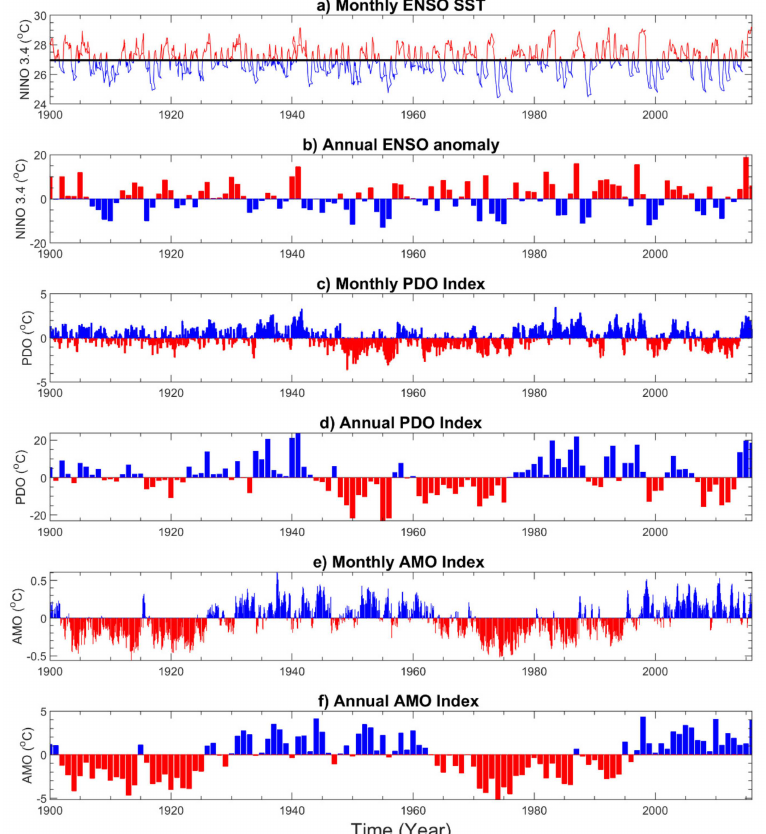
Figure 4. Long-term monthly and annual record of the three ocean–atmosphere interaction modes. ( a ) Monthly El Niño–Southern Oscillation (ENSO) sea surface temperature (SST): mean SST measured at NINO 3.4; ( b ) Annual ENSO anomaly: annual cumulative of the monthly SST anomaly; ( c ) Monthly Pacific Decadal Oscillation (PDO) index: monthly SST variability in the northern Pacific region; ( d ) Annual PDO index: cumulative of the monthly SST variability within a year; ( e ) Monthly Atlantic Multidecadal Oscillation (AMO) index: mean of the monthly SST anomalies in the North Atlantic Basin; and ( f ) Annual AMO index: sum of the monthly SST anomalies in a